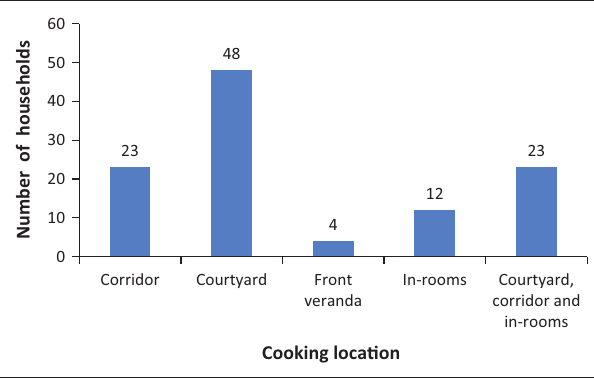
FIGURE 3: Cooking locations in Mchikichini